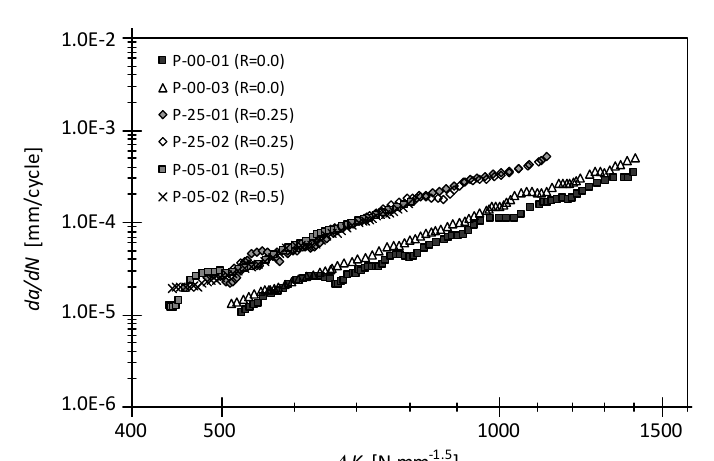
Table 2: Morrow constants of the S355 mid steel.